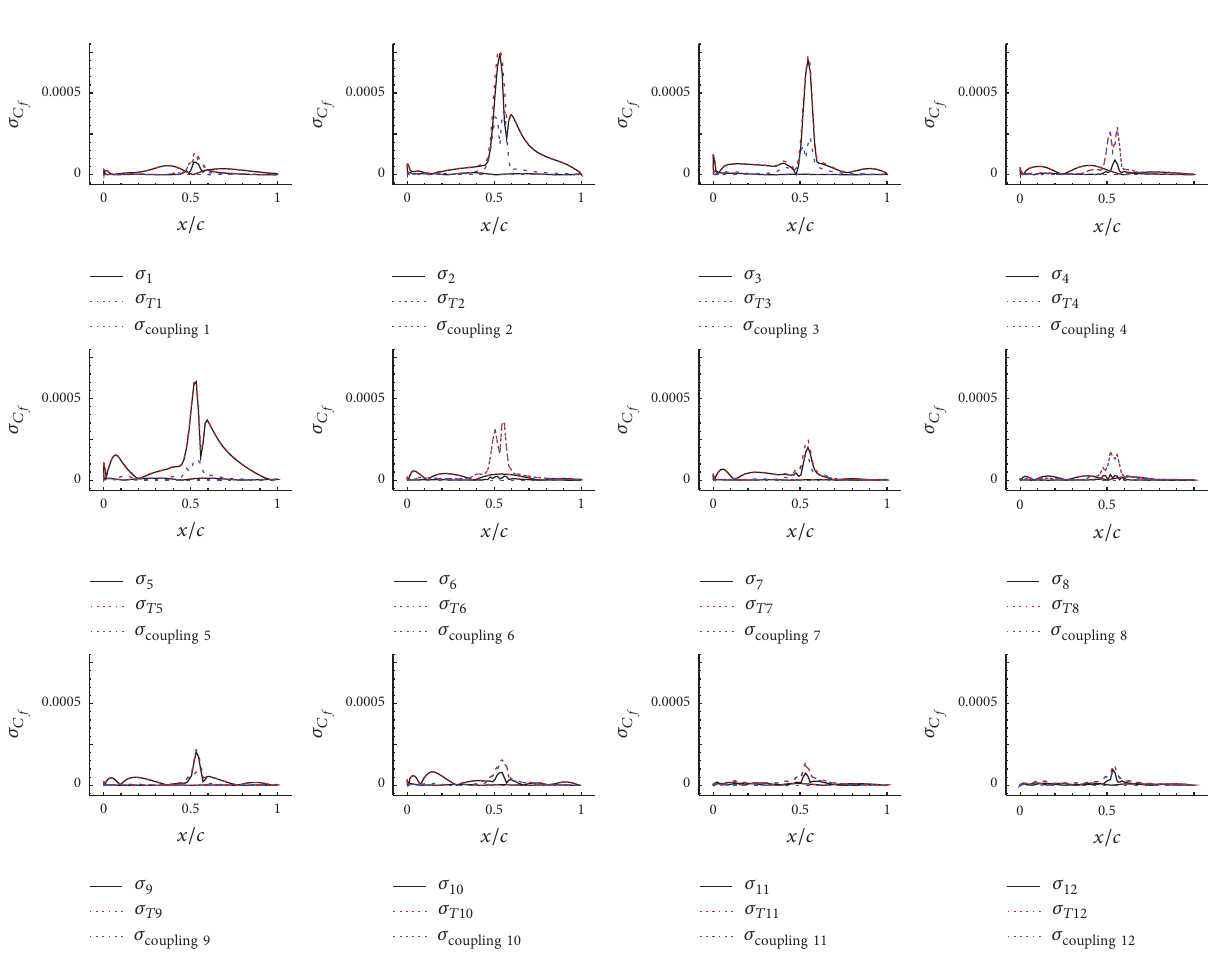
is the nonlinear coupling effect among uncertain variable 𝑖 and other uncertainty coupling 𝑖